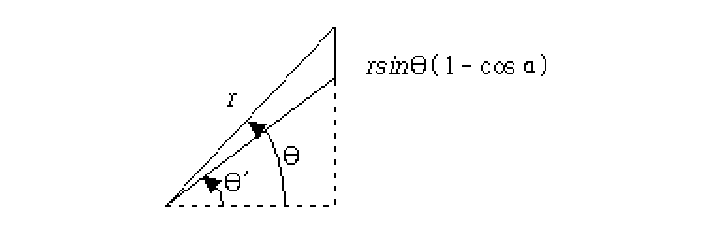
Figure 5. Angle difference of the two